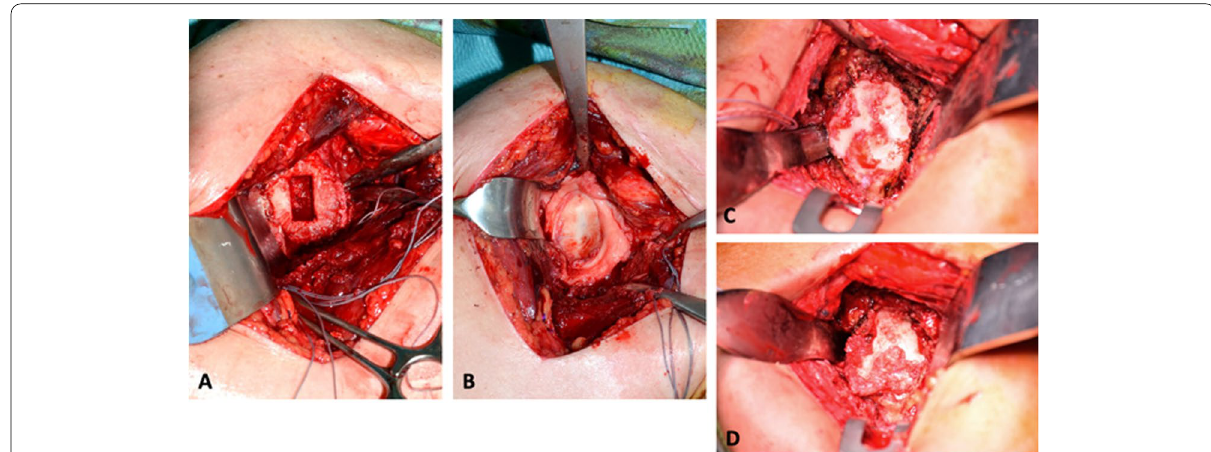
Fig. 3 Intraoperative imaging of the patient with an initially satisfactory course but revision 9 years after index procedure. Glenoid preparation at index procedure ( A ), glenoid allograft after implantation ( B ), eroded glenoid allograft at revision surgery ( C